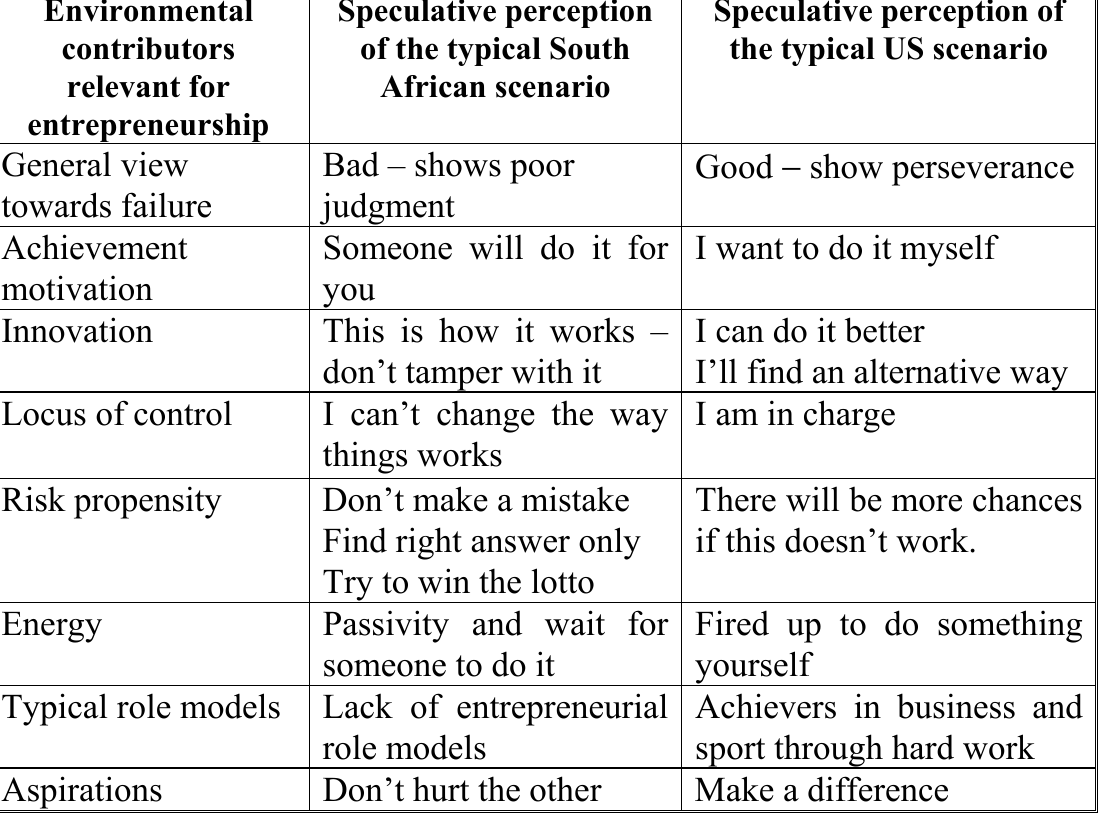
Contributors to entrepreneurial culture based on